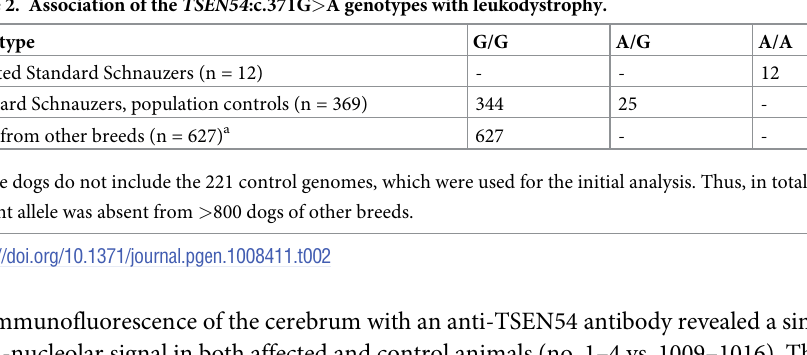
Immunofluorescence of the cerebrum with an anti-TSEN54 antibody revealed a similar intra-nucleolar signal in both affected and control animals (no. 1–4 vs. 1009–1016). The distri-